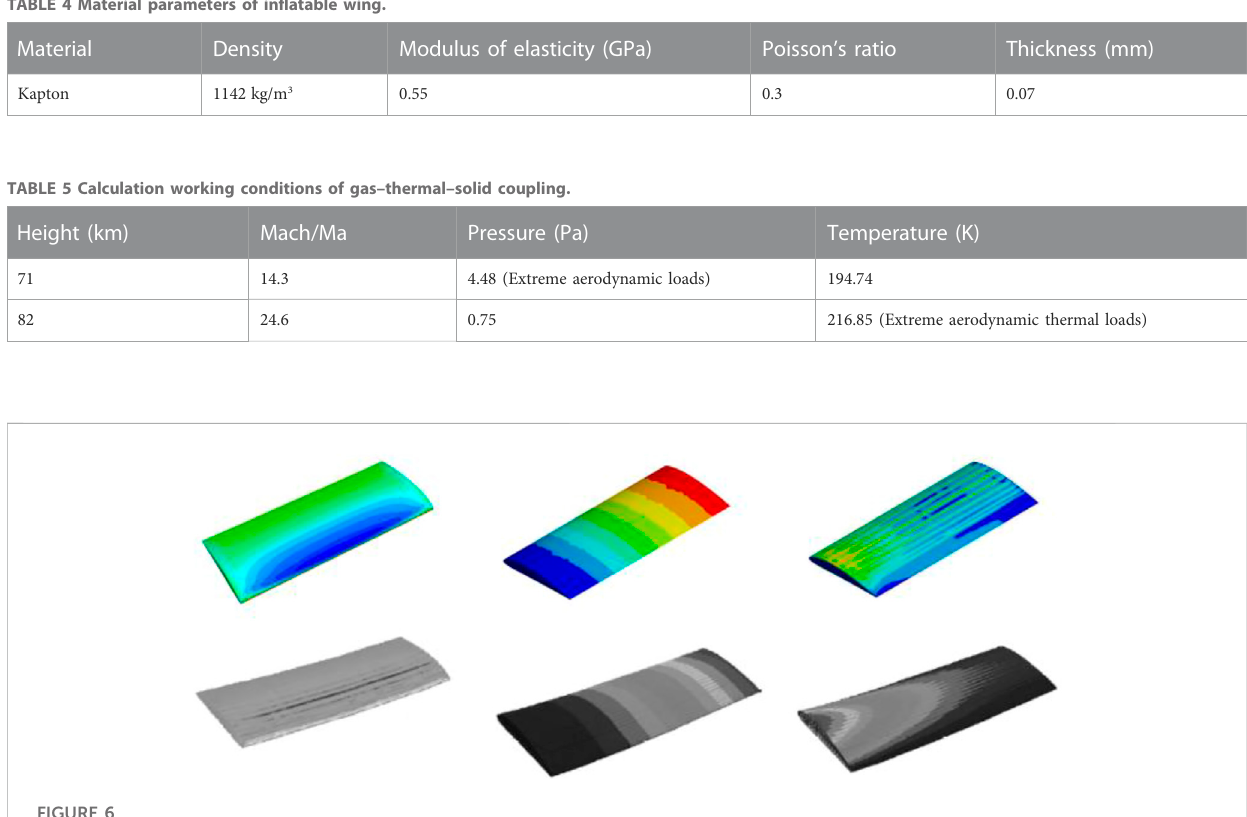
FIGURE 6 Comparison of coupling analysis results (top: method in this study, bottom: